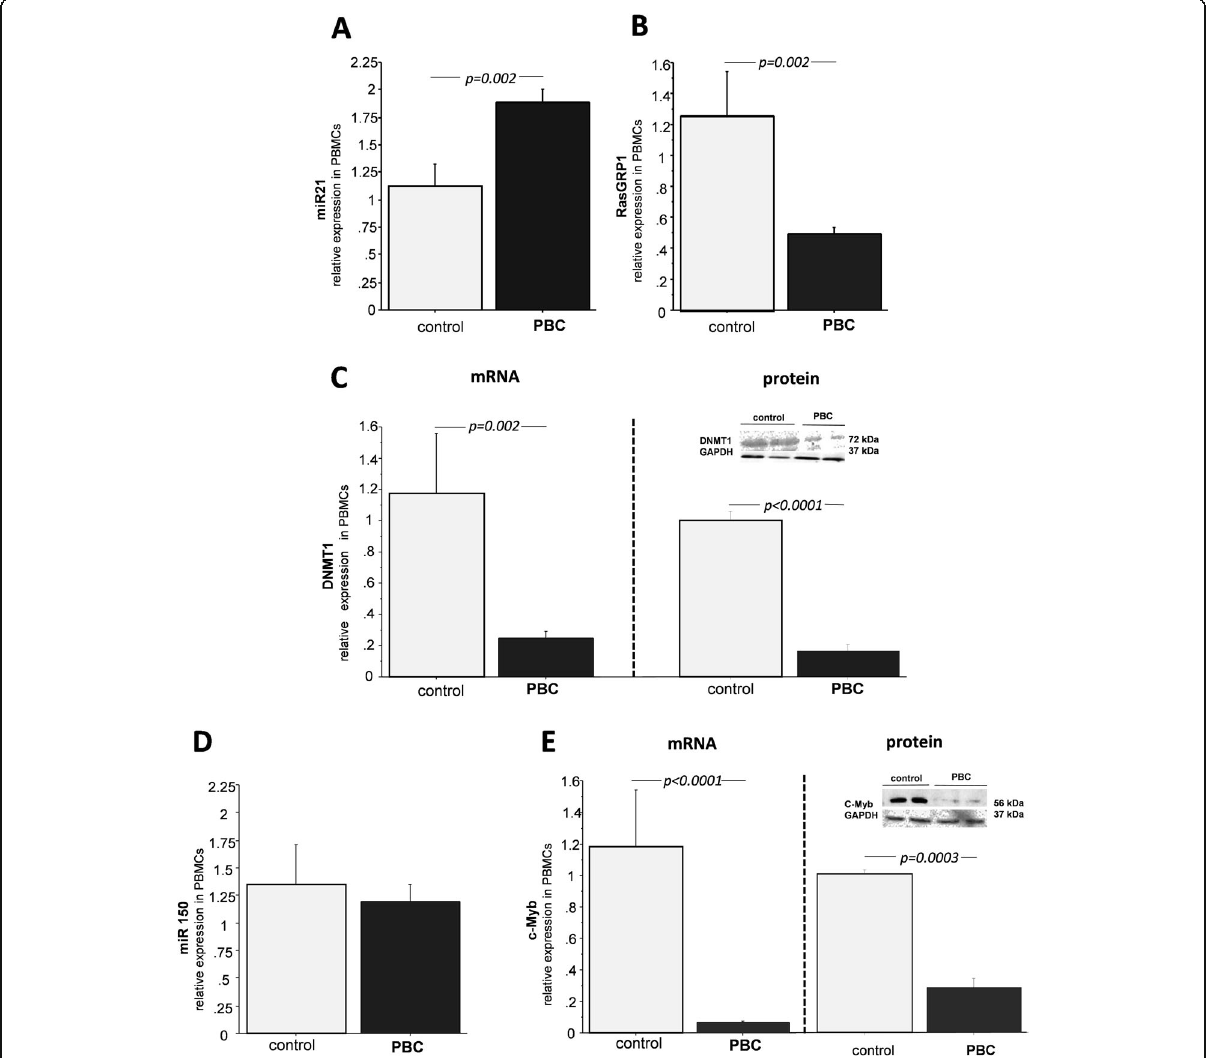
Fig. 4 The expressions of miR-21, miR-150 and their downstream target genes in peripheral blood mononuclear cells (PBMCs). MiR-21 expression was increased in PBMCs of patients with PBC in comparison to controls ( a ). The expression of RASGRP1 gene ( b ) and DNMT1( c ) mRNA and protein levels were reduced in PBMCs of PBC patients. MicroRNA 150 expression was unchanged ( d ),whereas cMyb mRNA and protein levels were significantly decreased in PBMCs of PBC patients ( e ). Bars indicate the mean ±